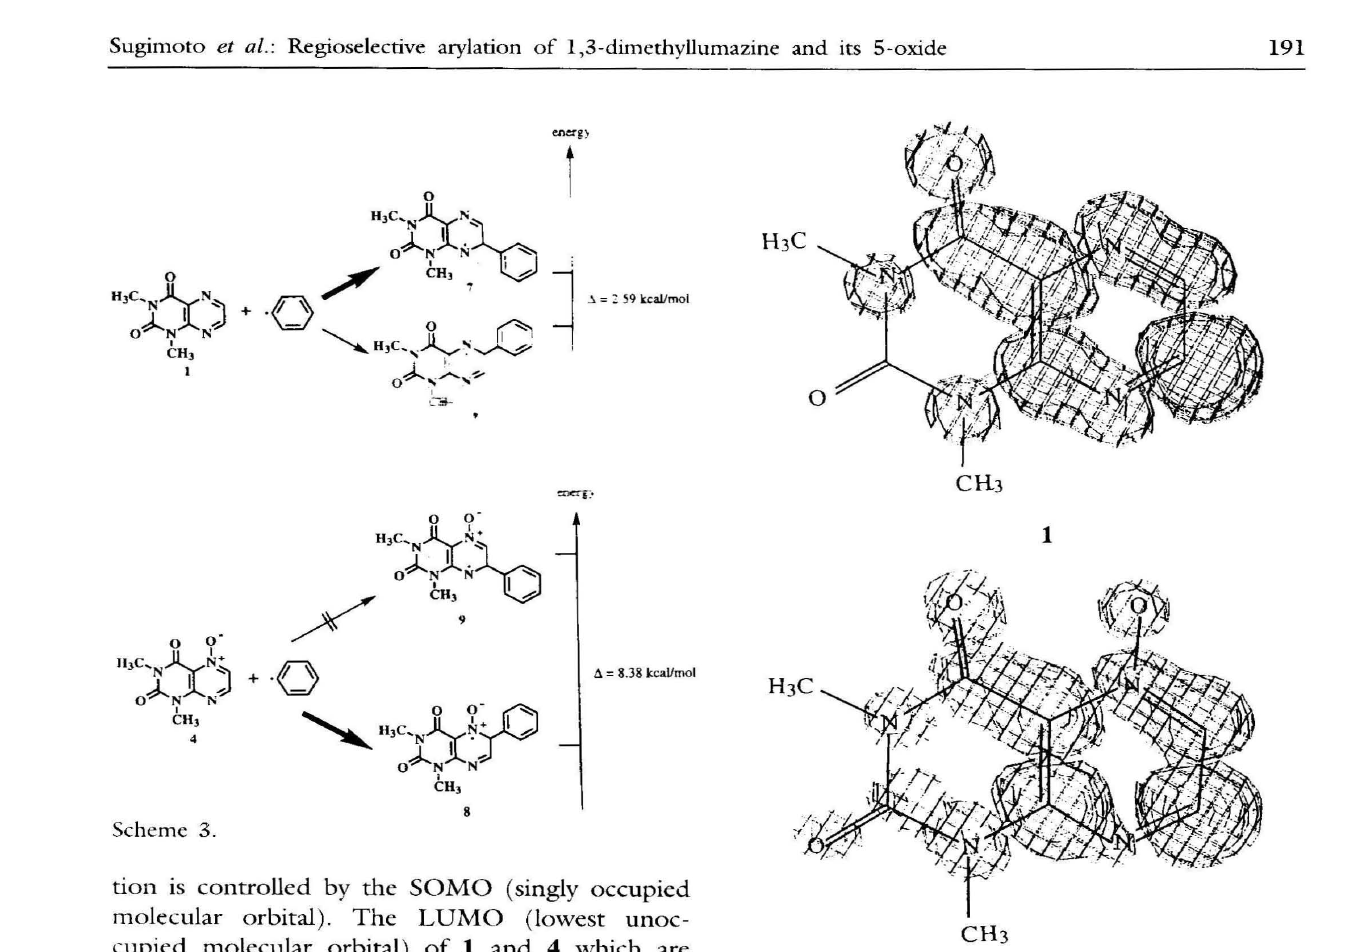
Figure 1. LUMO (SOMO) of 1 and